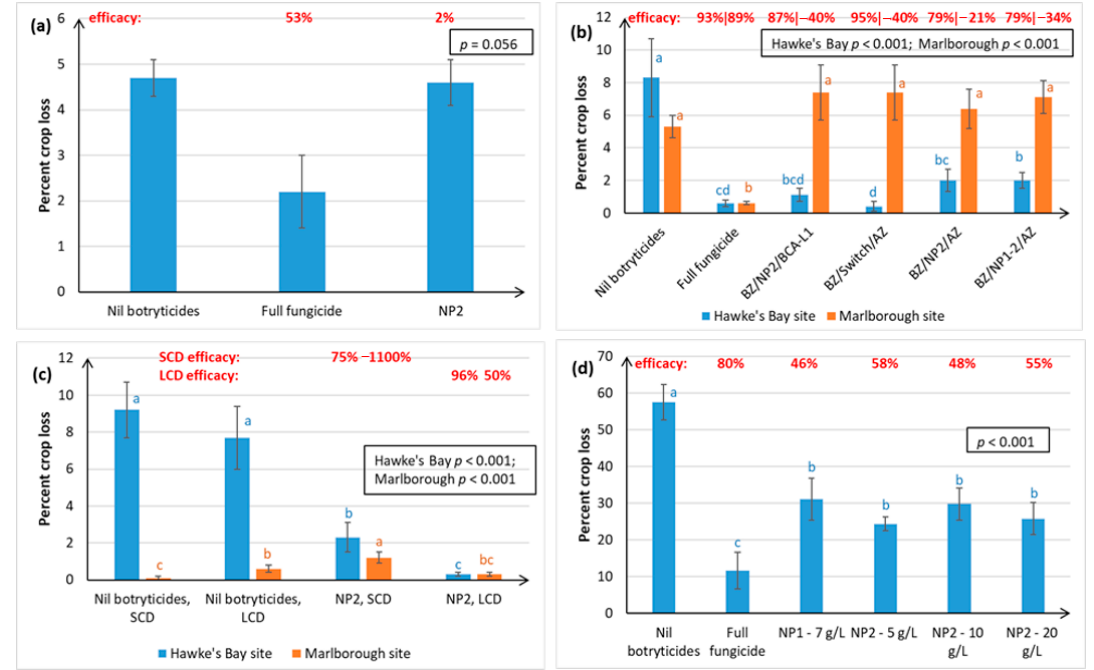
Figure 3. Percentage crop loss resulting from Botrytis bunch rot infections of Sauvignon Blanc (SB) and Riesling grape varieties, as assessed at harvest in April. Data were collected over 3 successive seasons for SB and one season for Riesling. Crop loss was calculated as described in Figure 2, and the efficacy calculation is outlined in Figure 1. Treatments are described in full in Tables S1 and S2, and briefly in Figure 1, except for the addition of treatments applied under different canopy densities, where leaf plucking and shoot thinning were used to create standard canopy densities (SCD), with bunch exposures of ca. 26%, and low canopy densities (LCD), with bunch exposures of ca. 80%. Each graph represents data from a separate trial, set up in a randomised block resign, with error bars indicating standard errors, boxed values showing probabilities obtained from ANOVA, and different letters indicating statistically significant differences from pairwise likelihood ratio tests, which are only presented when the ANOVA p ≤ 0.05. The concentration of the active ingredient in the NP formulation is indicated in parentheses for each specific experiment. ( a ) SB, Season i, Hawke’s Bay site, NP2 (5 g/L); ( b ) SB, Season ii, Hawke’s Bay and Marlborough sites, NP1 (5 g/L) and NP2 (5 g/L); ( c ) Season iii, Hawke’s Bay and Marlborough sites, new formulation of NP2 (30 mL/L); ( d ) Riesling, Hawke’s Bay, NP1 (7 g/L) and NP2 (5, 10 and 20